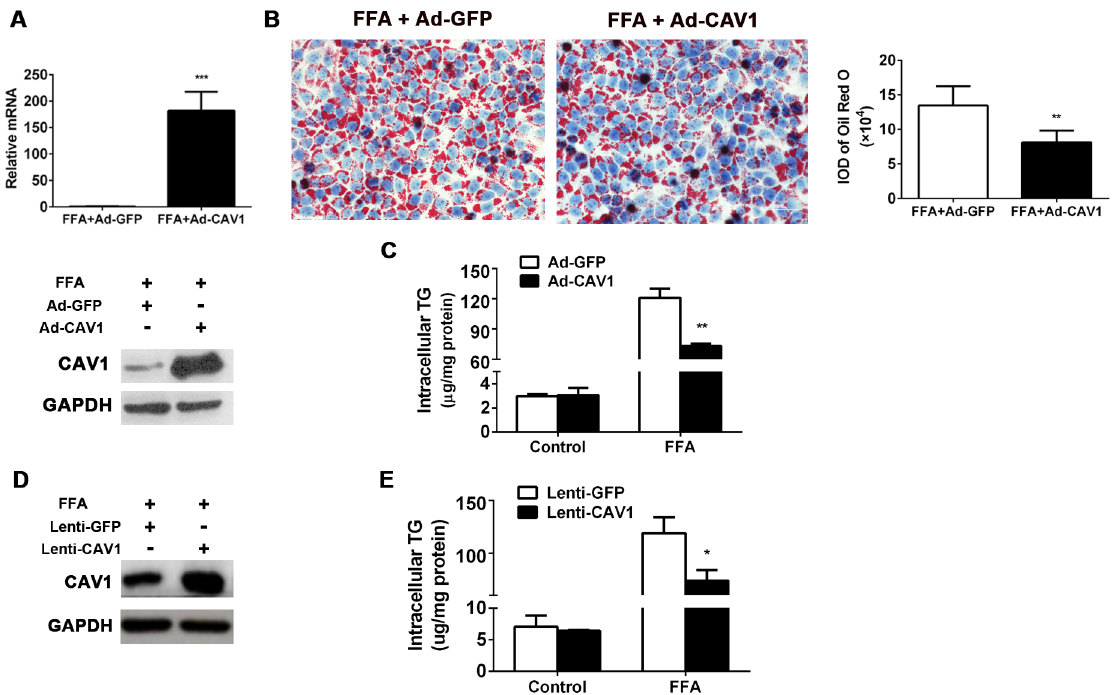
Fig 3. CAV1 overexpression ameliorated fat accumulation in L02 cells and AML12 cells induced by FFA. CAV1 was overexpressed using the adenovirus recombination system via a transient transfectionin L02 cells and the lentivirus-constructed stable transfectionsystem in AML12 cells. (A-C) L02 cells were transfected with an adenovirus recombination plasmidcontaining full-length human CAV1 DNA to overexpress CAV1 (Ad-CAV1); an adenovirusempty vector expressingGFP (Ad-GFP) served as a control. After transfection for 24 h, cells were challengedwith 1 mM FFA for another 48 h. (A) CAV1 mRNA and protein levels in FFA-treated L02 cells transfected with Ad-GFP or Ad-CAV1. (B) Representative Oil Red O staining of FFA-treated L02 cells transfected with Ad-GFP or Ad-CAV1. The averageintegratedopticaldensity (IOD) of lipid droplets stainedwith Oil Red O from FFA treated cells was measuredwith an Image-ProPlus software.(C) Triglycerides werequantified from L02cellstreatedwith or withoutFFA transfectedwithAd-GFP or Ad-CAV1.(D-E) AML12hepatocytes weretransfectedwiththe lentivirus system containing full-length mouseCAV1 DNA to stablyoverexpressCAV1(Lenti-CAV1); a lentivirusemptyvector expressing GFP (Lenti-GFP) servedas a control.Cellswerechallengedwith 1 mM FFA for 48 h. (D) CAV1 proteinlevelsin FFA-treated AML12cellstransfected withLenti-GFP or Lenti-CAV1. (E) Triglycerides werequantified from AML12cellstreatedwith or withoutFFA transfectedwith Lenti- GFP or Lenti-CAV1.The resultsare expressedas the mean ± SD of 3 independent experiments. ( * P < 0.05 and *** P < 0.001).